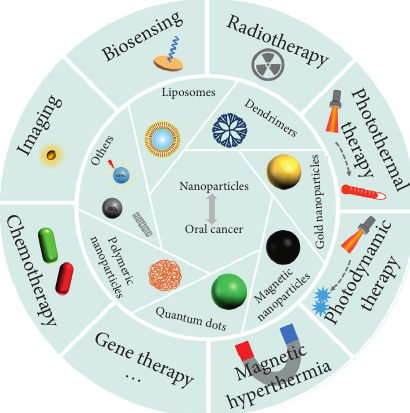
Figure 1: Nanoparticles for oral cancer diagnosis and